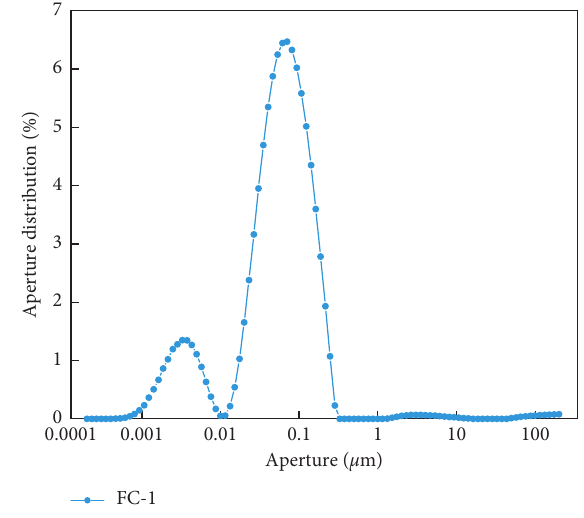
Figure 2: The pore size distribution of